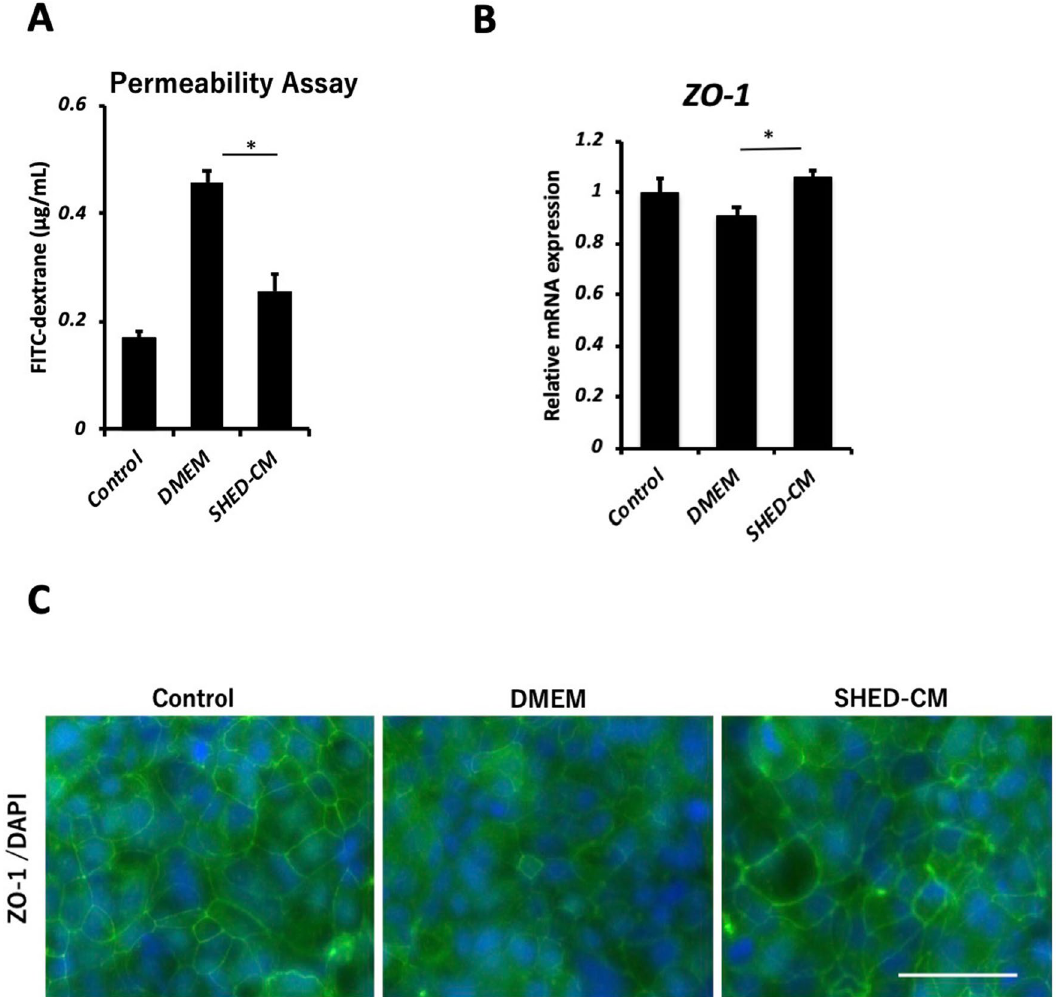
Figure 7. SHED-CM protects functionality of Caco-2 monolayers. ( A ) Quantification of paracellular FITC- dextran flux through Caco-2 monolayers treated with IFN-γ and TNF-α. ( B ) Relative mRNA expression of ZO-1 in Caco-2 cells. Data represent mean ± SEM. * P < .05. ( C ) Representative images of immunofluorescence staining of Caco-2 monolayers. Scale bar = 200 μm. Abbreviations: IFN; interferon; TNF, tumor necrosis factor; FITC, fluorescein isothiocyanate; DMEM, Dulbecco’s modified Eagle’s medium; SHED-CM, serum- free conditioned medium from stem cells derived from human exfoliated deciduous teeth; ZO-1, zonula occludens-1; DAPI, 4’,6 ‐ diamidino ‐ 2 ‐